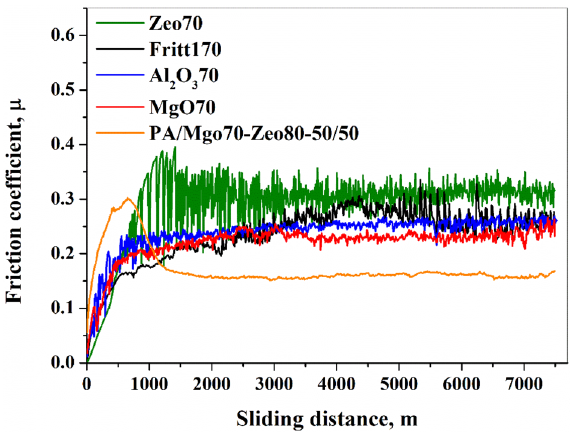
Figure 8. Friction coefficient curves with different types of fillers and filler